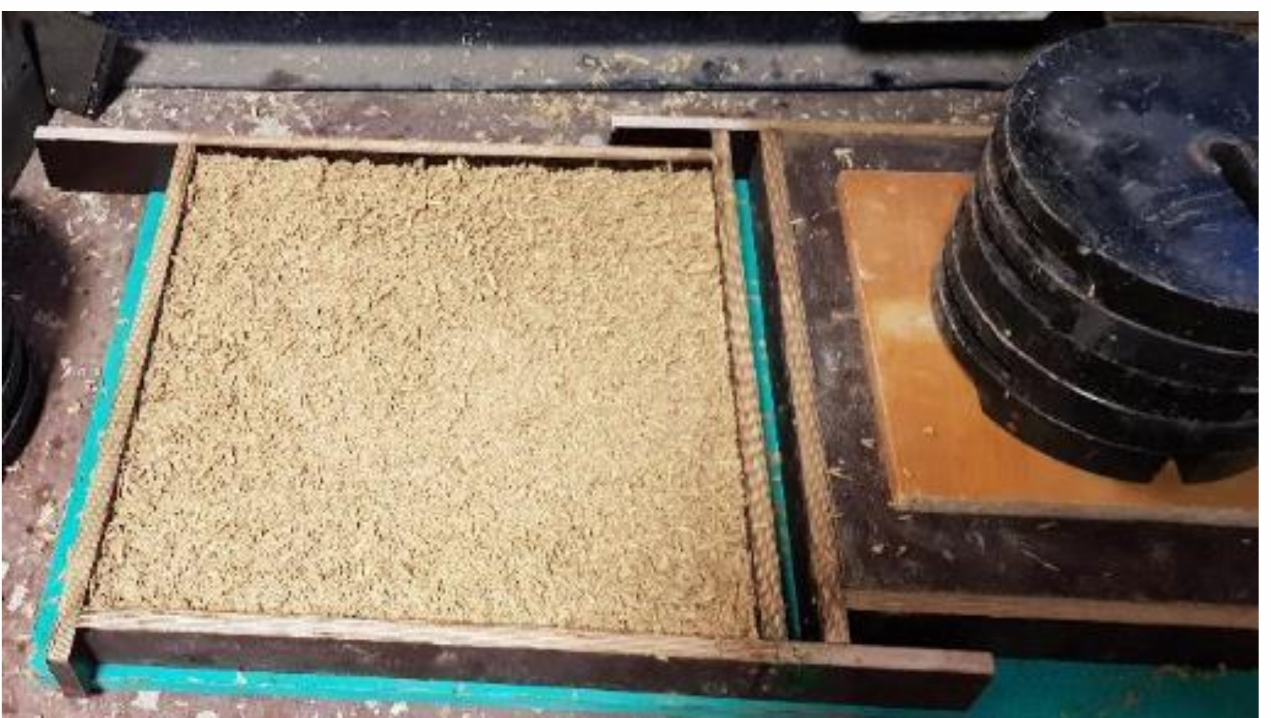
Figure 2. Hemp bio-composite sample (500 mm × 500 mm × 50 mm) preparation kept under pressure.